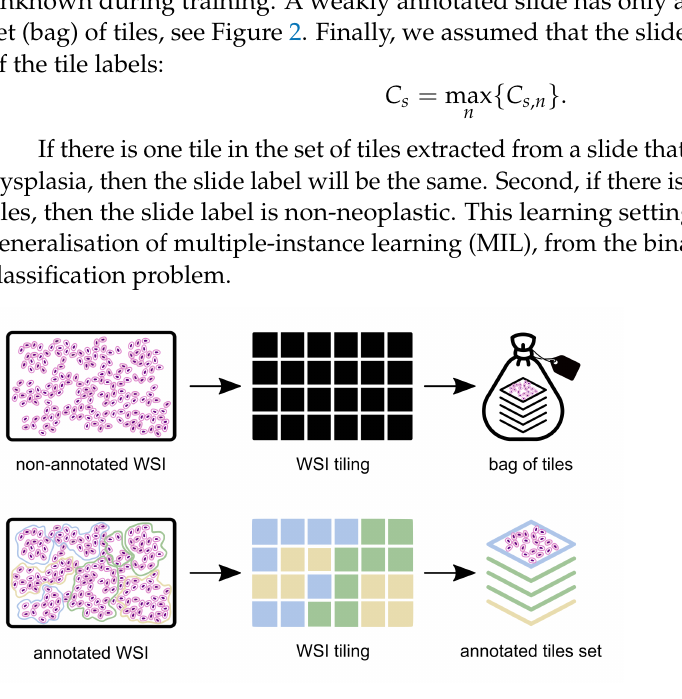
Figure 2. Labelling scheme: weakly annotated slides ( above ) have only a global label, from the pathology report, whereas a strongly annotated slide ( below ) has labels for each individual tile, retrieved directly from the pathologists’ spatial